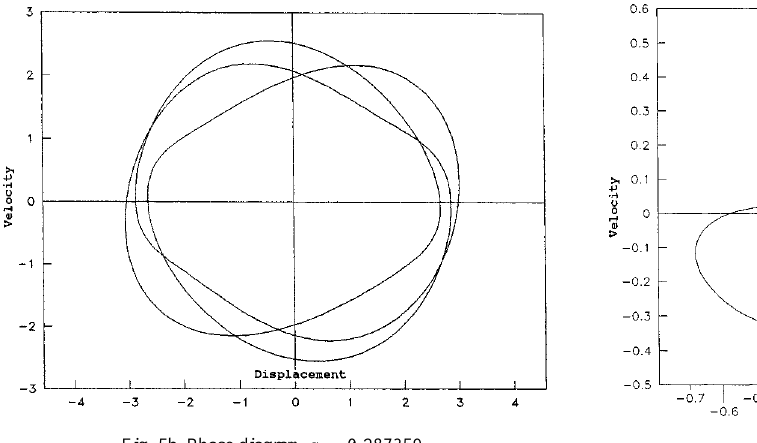
Fig. 5b. Phase diagram q = 0 : 287359.